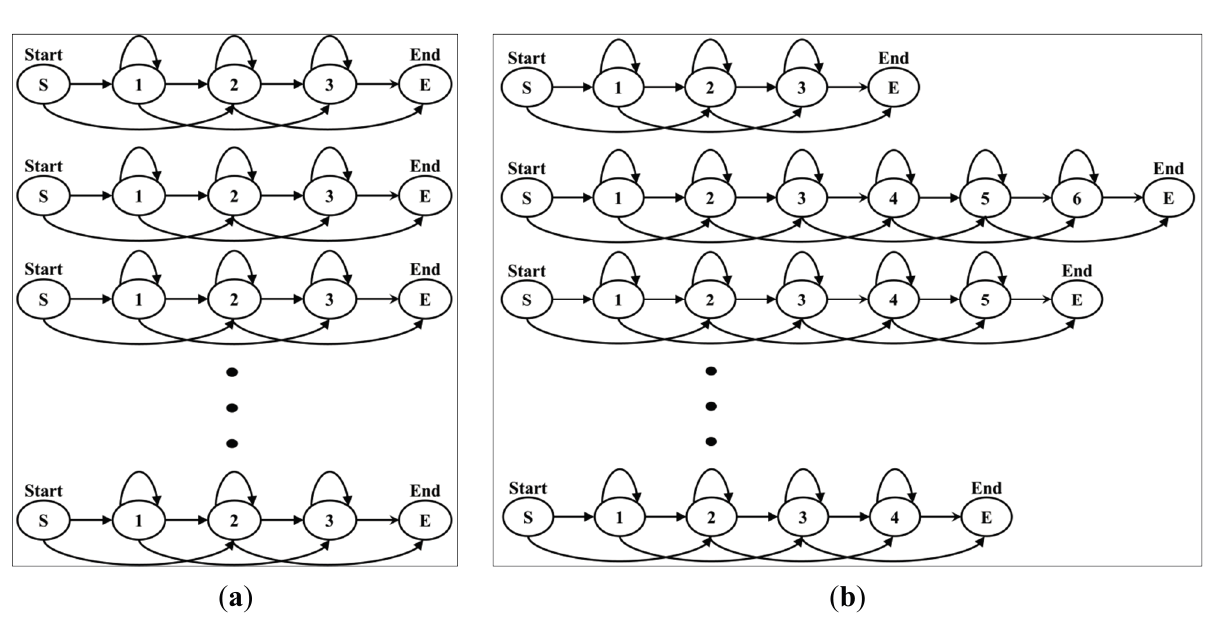
Figure 16. Example structure of fixed and flexible action models: ( a ) fixed action models; ( b ) flexible action models.